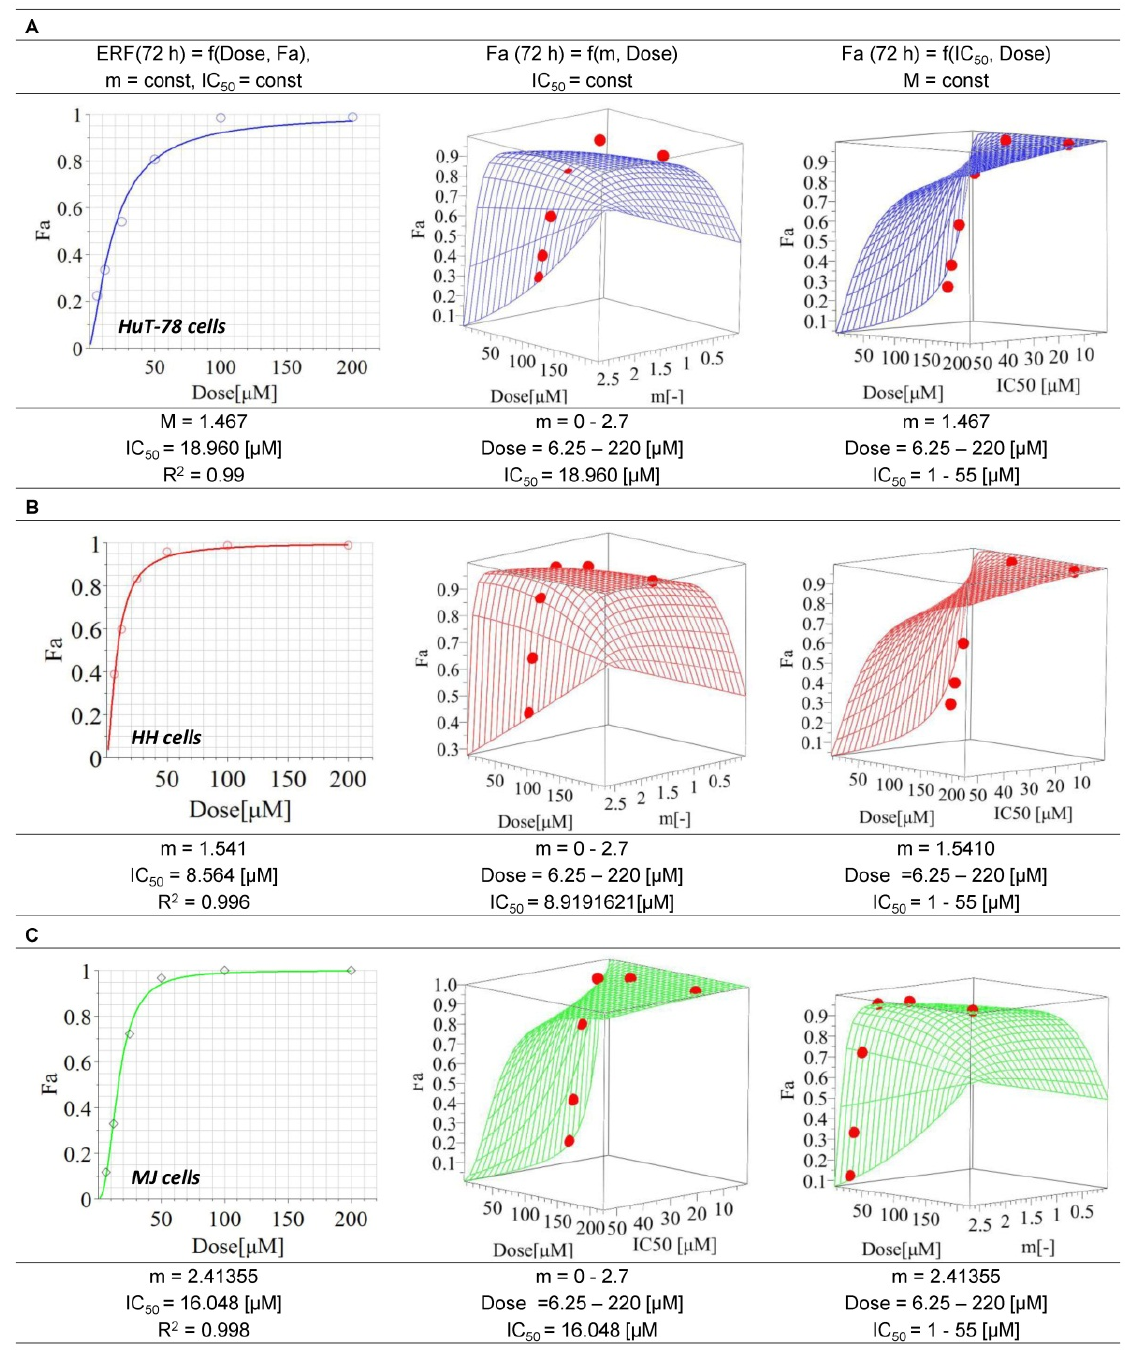
Figure 1. Median inhibitory concentrations of erufosine on the cell lines HuT-78, HH and MJ. Legend: ERF—erufosine; m—hillslope; R 2 —coefficient of determination; IC 50 —inhibitory concentration 50% (median inhibitory concentration); Fa—drug effect; ( A )—Cell line HuT78 (Sézary Syndrome); ( B )—Cell line HH (cutaneous T-cell lymphoma); ( C )—Cell line MJ (Mycosis fungoides).